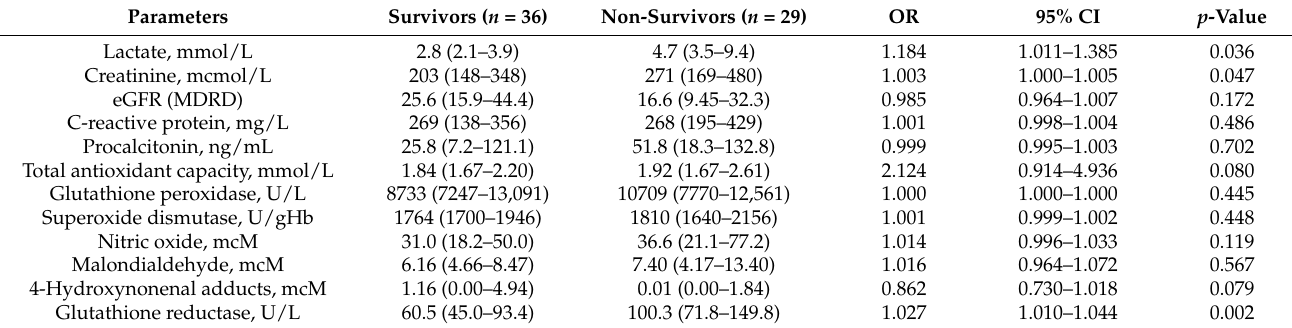
Table 2. Univariable comparison of blood chemistry parameters between the two patient groups.